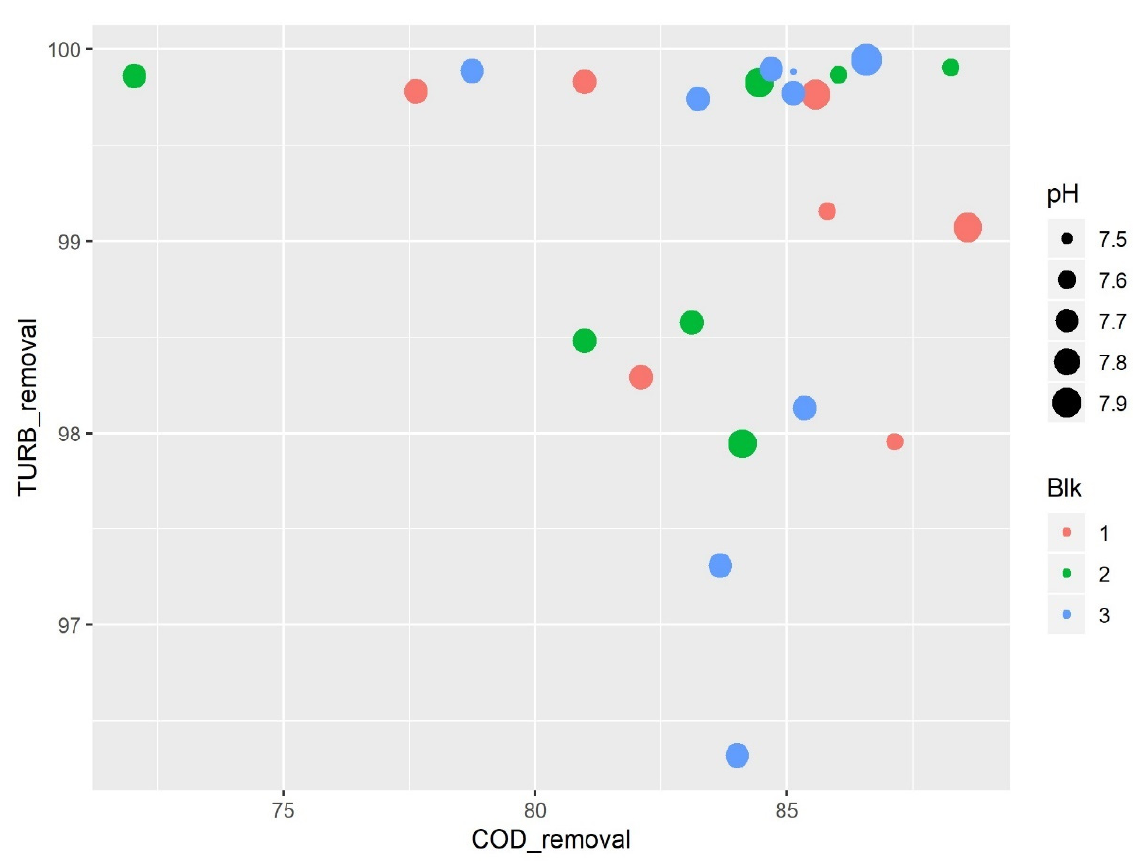
Figure 4. Effect of pH on COD and turbidity removal. COD: chemical oxygen demand, TURB: Turbidity; Blk: Blocks number (Blk1, Blk2, Blk3).